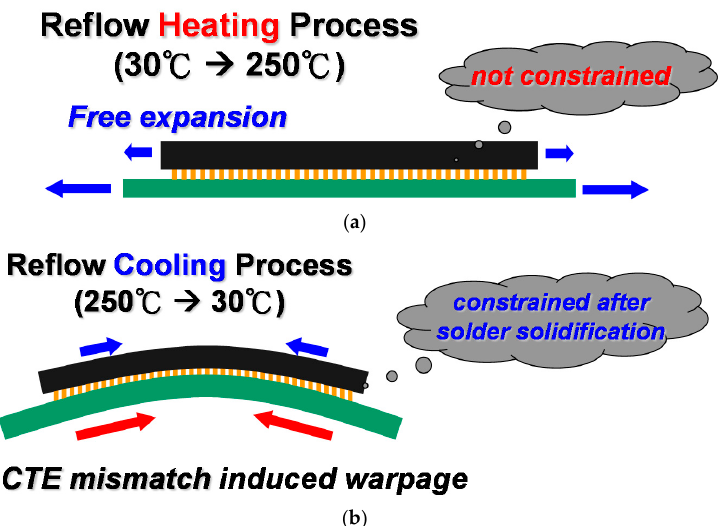
Figure 2. ( a ) No constraint between DIMM socket and PCB during the reflow heating process, and ( b ) thermally-induced warpage of the PCB assembly due to a coefficient of thermal expansion (CTE) mismatch during the reflow cooling process.